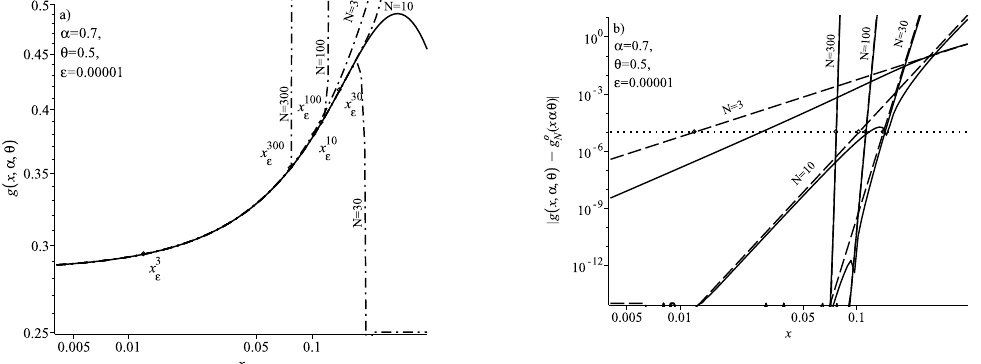
Figure 1. ( a ) Probability density g ( x , α , θ ) for the parameter values shown in the figure. The solid curve is an integral representation (3), and dash-dotted curves are the series (12) for different values of the number of N summands in total. Circles are the position of the threshold coordinate (36) for each value N . ( b ) The graph of the absolute error of calculating the probability density using a series (12) for the case given in Figure ( a ). Solid curves are the exact value of the absolute error | g ( x , α , θ ) − g 0 ( x , α , θ ) | , dashed curves are the estimate (13), and the dotted line shows the position N of the specified accuracy level ε . Circles demonstrate the location of the threshold coordinate (36) for the specified values N